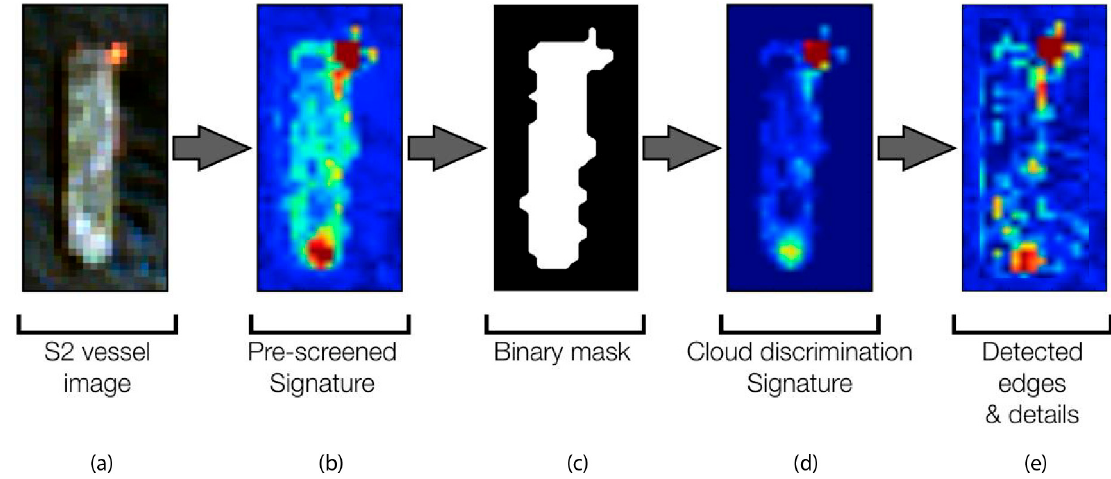
Figure 8. Vessel detection stages: columns (left to right) show: ( a ) Sentinel-2 MSI image; ( b ) pre-screened signature; ( c ) binary mask; ( d ) cloud discrimination signature; ( e ) detected edges and details. Pixel size is 10 × 10 metres.